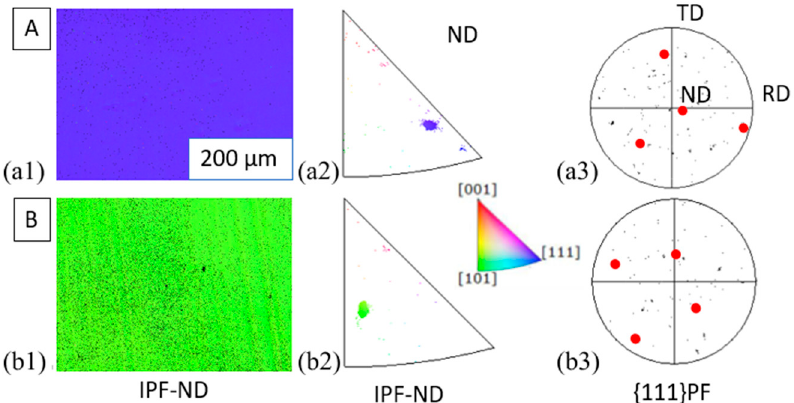
Figure 1. ( a1 – a3 ) and ( b1 – b3 ) are EBSD maps for undeformed A-oriented and B-oriented samples, respectively. ( a1 – a2 ) and ( b1 – b2 ) are the inverse pole figure in the loading direction (IPF-ND). ( a3 ) and ( b3 ) are the pole figure of the {111} plane ({111}PF) with red dots representing their orientation.